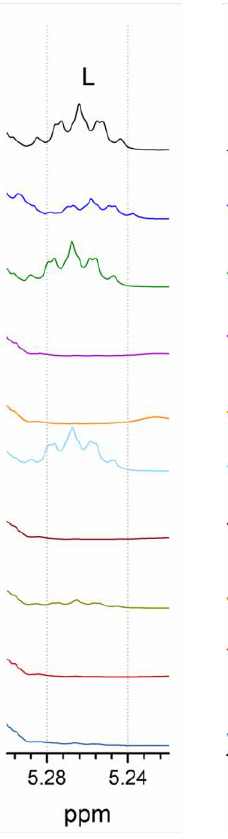
Figure 4. 1 H NMR spectra of the UCO and polyols in specific chemical shift ranges.